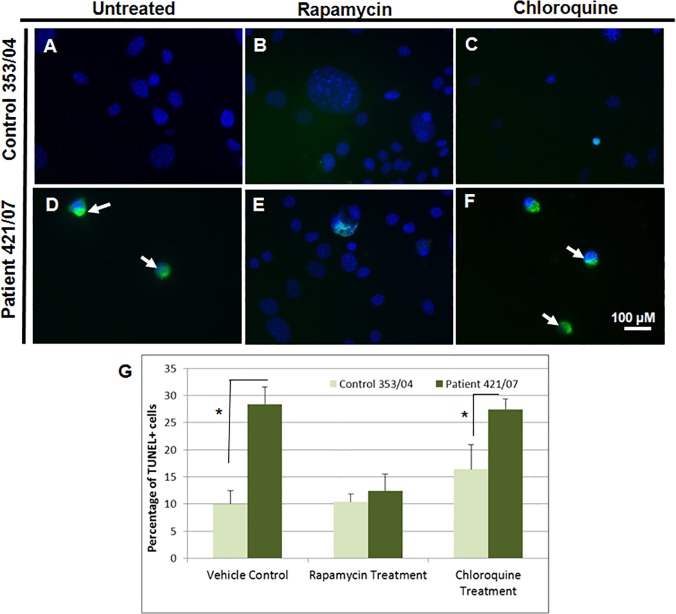
TUNEL analyses of autophagy signaling cascade in the patients’ myoblasts with VCP disease treated with either rapamycin or chloroquine.Control 353/04 subjects’ myoblasts (A) untreated, (B) 10μM rapamycin-treated and (C) 10μM chloroquine-treated stained with TUNEL. VCP patients’ 421/07 myoblasts (D) untreated, (E) 10μM rapamycin-treated and (F) 10μM chloroquine-treated stained with TUNEL. Scale bar represents 100 μM. Data represents triplicate studies. (G) Percentage of TUNEL+ cells in untreated, rapamycin- and chloroquine-treated control and VCP patients’ myoblasts. Data represents triplicate studies. Statistical significance is denoted by *p<0.005 by Student one-tailed t-test.